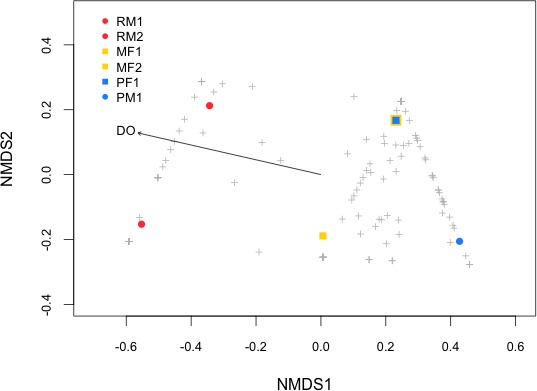
 NMDS (Non-metric Multidimensional Scaling) plot of the samples (see symbols) based on Bray–Curtis distance matrix of genes OTUs from fish stomach microbiome.Physicochemical properties were fitted onto the NMDS ordination and only significant variables are shown (p < 0.1). Symbol abbreviations: RM1, R, Rascón; M, Micos; P, Pachón; M, male; F, female.